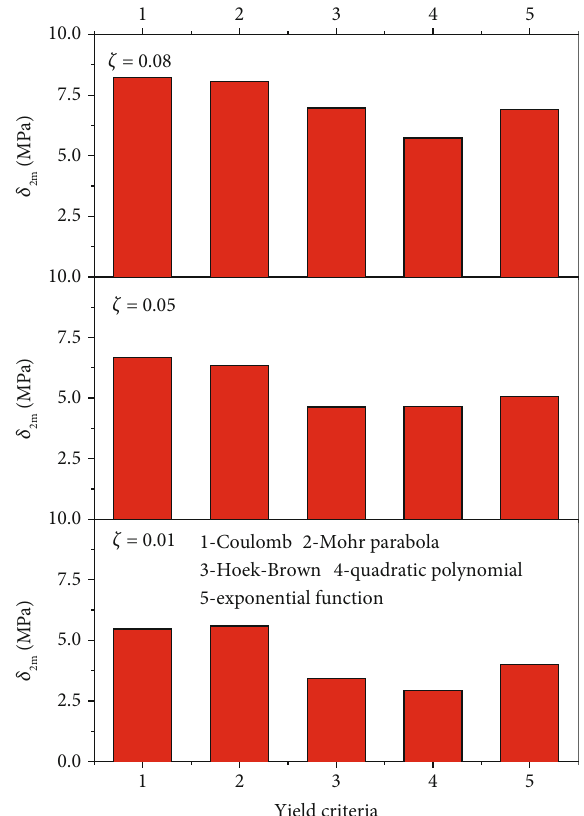
Figure 4: Mean fi tting deviations of yield criteria for saturated DT coal